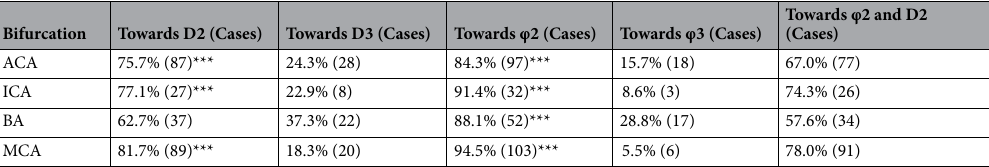
(Table 3). Similarly, 91.4% (32 cases) and 77.1% (27 cases) ICA bifurcation aneurysms deviated towards the smaller